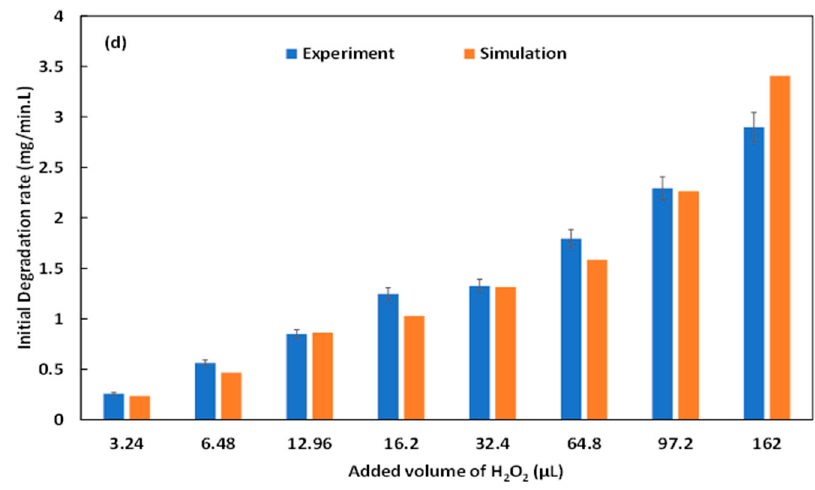
Figure 6. Experimental ( a ) and simulated ( b ) kinetics of Galvano-Fenton degradation of NBB vs. time, and their corresponding simulated kinetics of hydroxyl radical production ( c ), and comparison of the initial degradation rates obtained experimentally and numerically ( d ) with different concentrations of added hydrogen peroxide (pH 3 and initial concentration of NBB: 5 mg · L − 1 ).